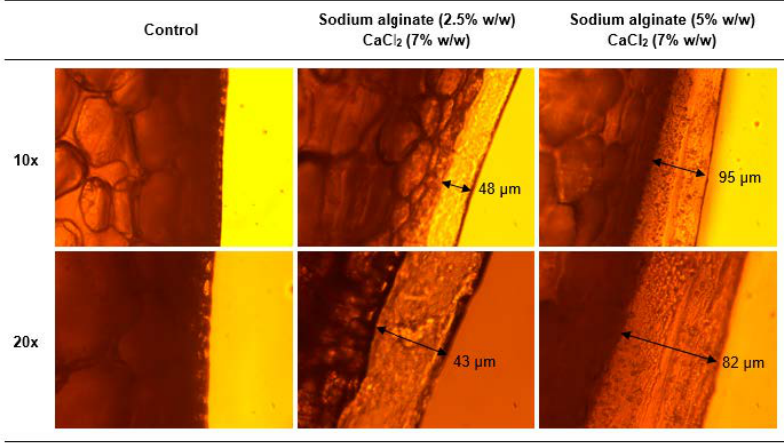
Figure 2. Microscopy images of uncoated and coated tomato peels prepared at different sodium alginate concentration and fixed dipping times (120 s in each solution), as described in the figure, and for two different magnifications (10 × and 20 × ).